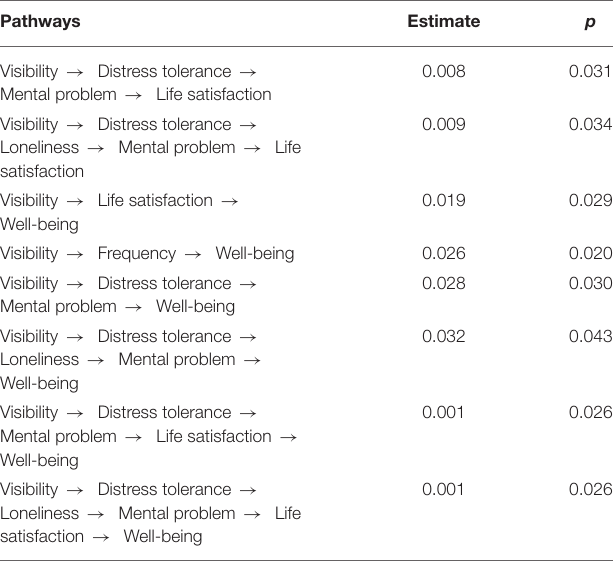
TABLE 5 | Statistically significant indirect pathways from visibility of nature to prisoners’ life satisfaction and well-being. Pathways Estimate p Visibility → Distress tolerance → Mental problem → Life